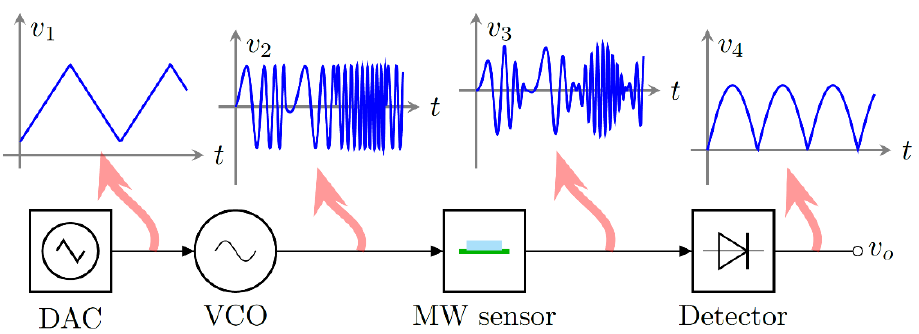
Figure 5. Signal transformation along the electronic reader workflow: v 1 triangular signal from the DAC, v 2 frequency sweep from the VCO, v 3 reflected signal by the MW sensor, v 4 acquired signal by the Arduino ADC.